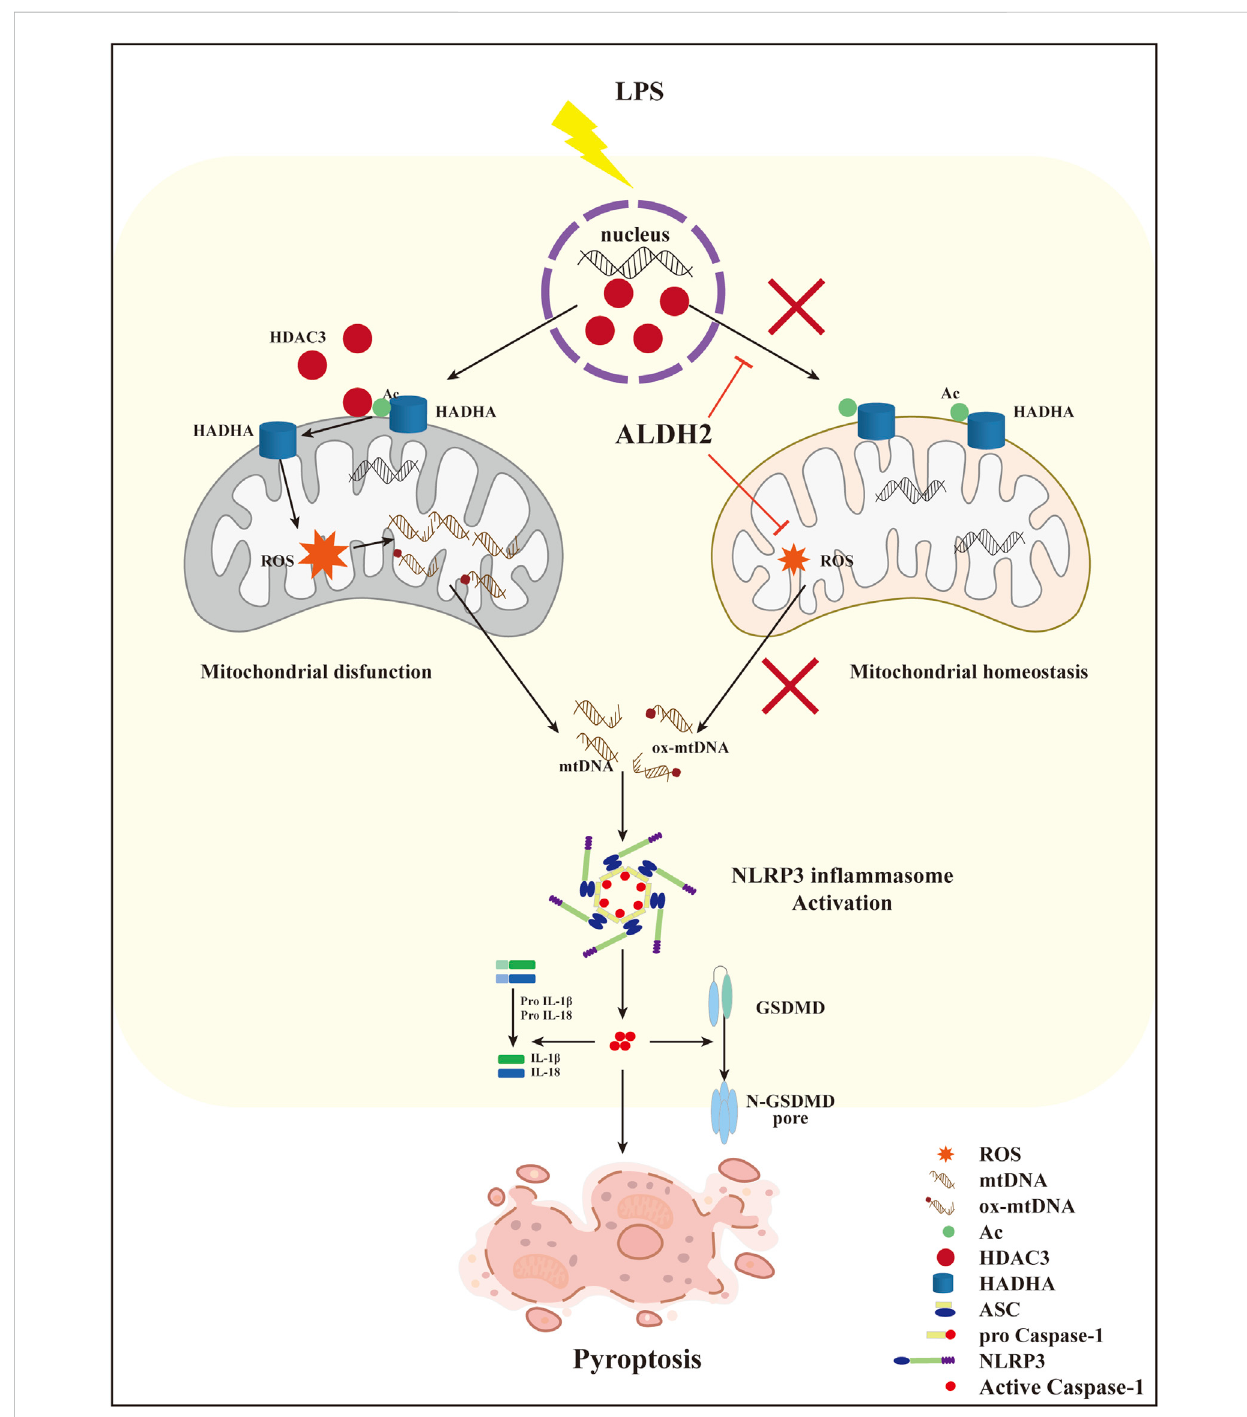
FIGURE 8 A diagram showing ALDH2 as a therapeutic target to protect against septic shock-induced myocardial